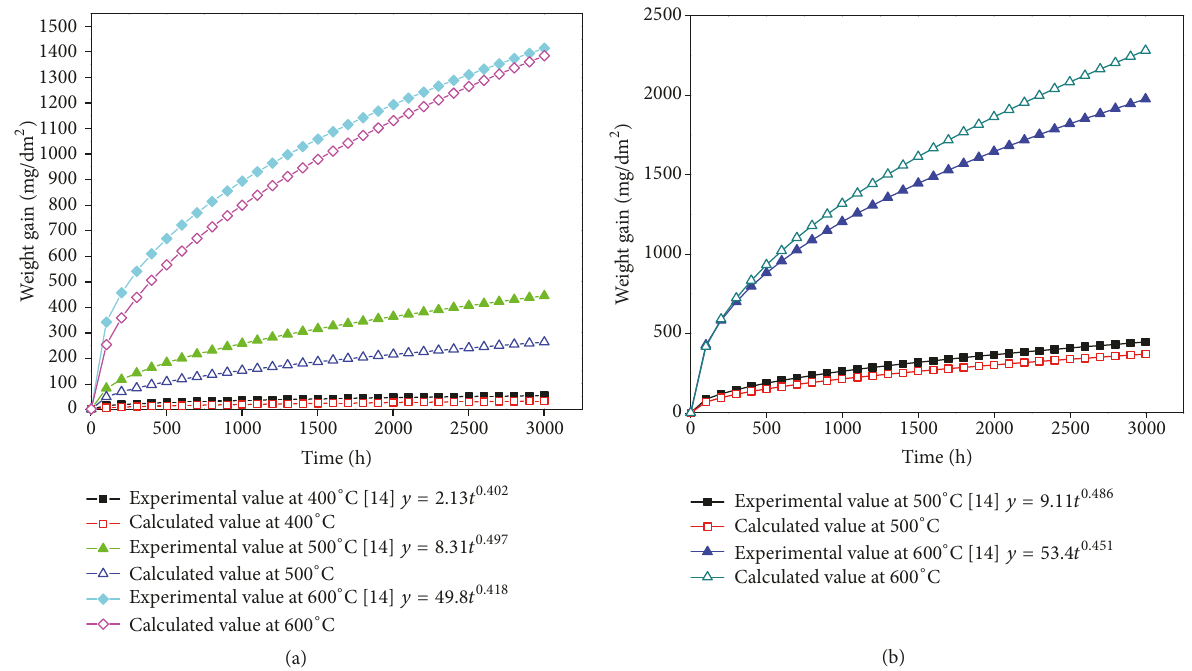
Figure 3: Experimental weight gain by oxidation of HCM12A (a) and NF616 (b) in supercritical water at different temperatures compared to the simulation.